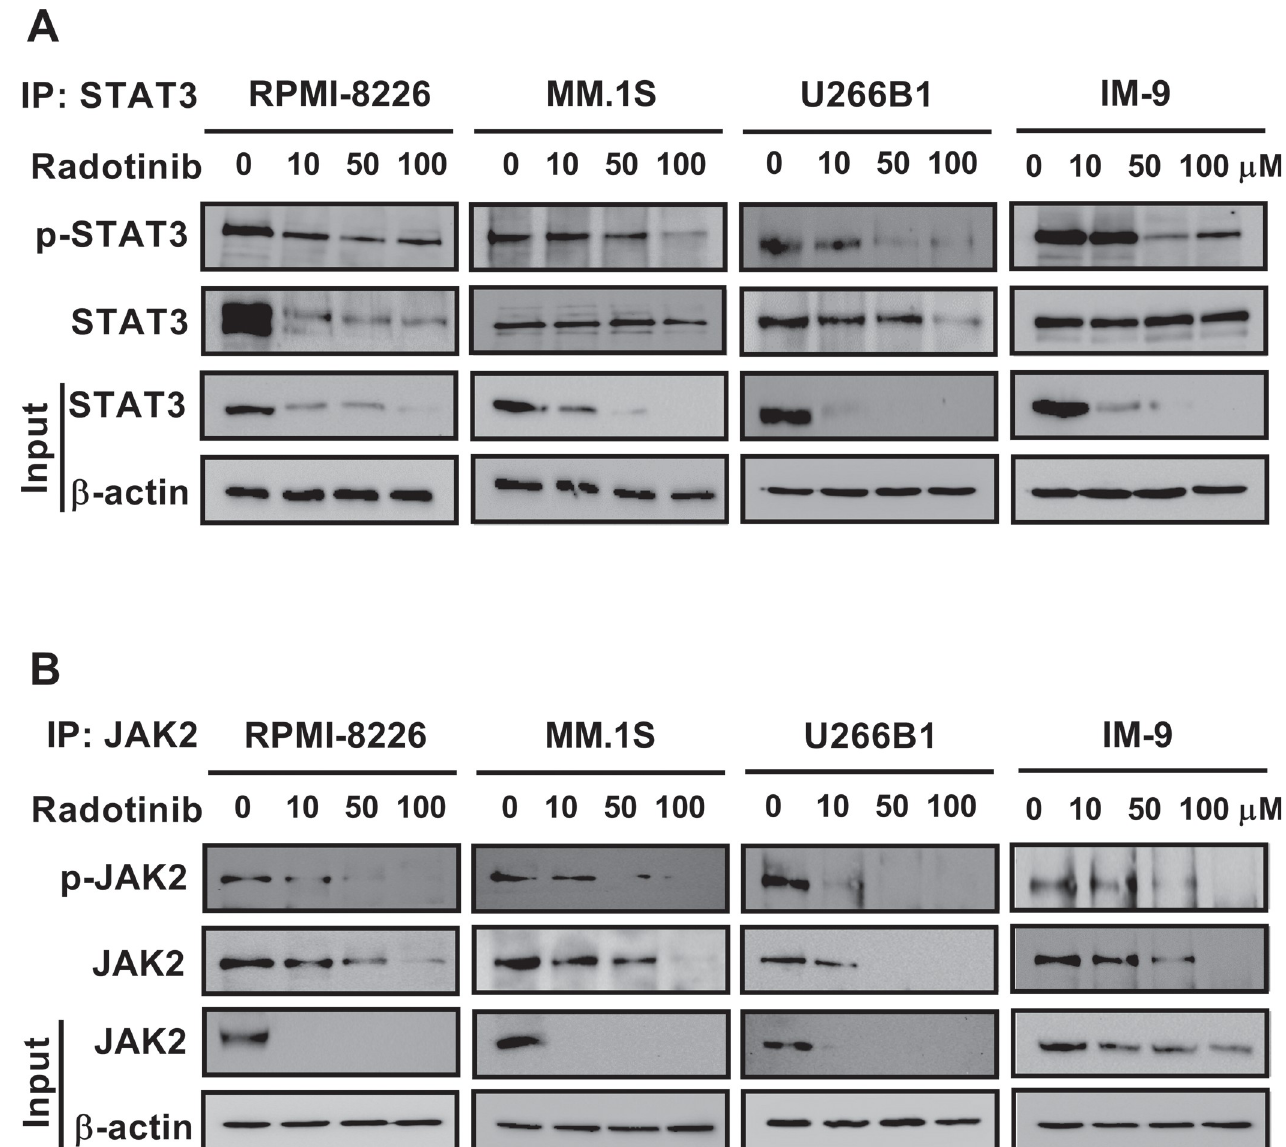
Fig 3. Radotinib strongly inhibits the activity and expression of STAT3 and JAK2 in various MM cells. MM cells were incubated with 0, 10, 50, and 100 μ M radotinib for 72 h. (A) Effect of radotinib on the activity and expression of STAT3. (B) Effect of radotinib on the activity and expression of JAK2. The membrane was stripped and reprobed with anti- β -actin mAb to confirm equal